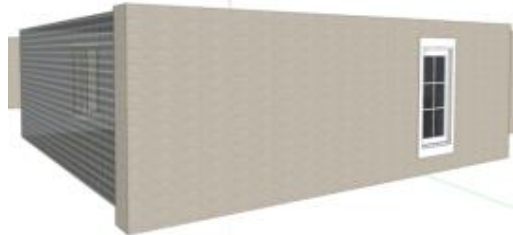
Figure 4: Exterior WallSurface of the designed